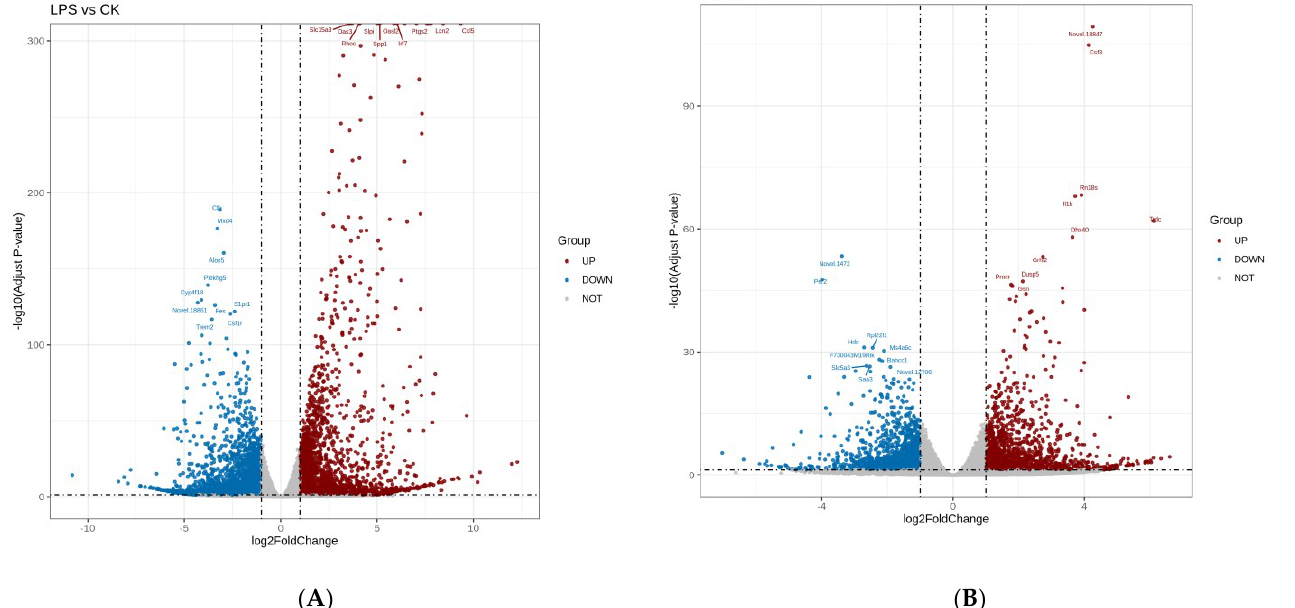
Figure 2. The volcano plots of LPS/CK and EG/LPS. ( A ): The volcano plots of LPS/CK. ( B ): The volcano plots of EG/LPS. A dot represents a gene. The gray area is for no significant difference The red dot represents a significant upregulated gene. The blue dot represents a significant downregulated gene. The larger the adjusted p −value, the more significant it is. The larger the |log2foldchange|, the greater the fold of difference in gene expression.